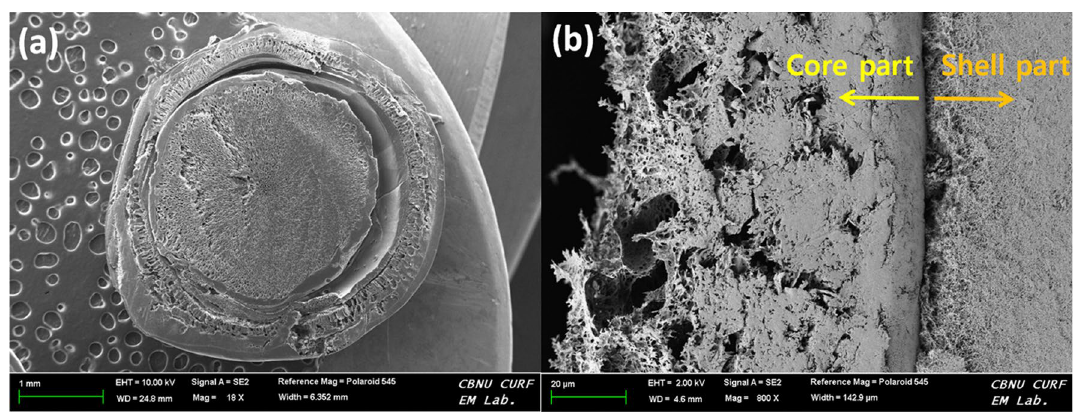
Figure 2. FE-SEM images of freeze dried cellulose-coated CS bead ( a ) and intersection of CS and cellulose layers ( b ). Scale bars represent 1 mm and 20 µm